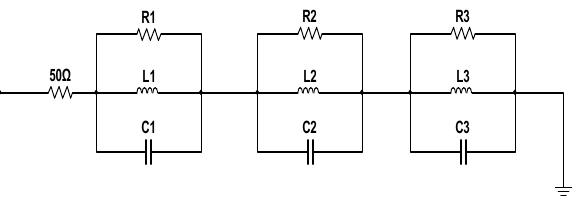
Figure 6. The equivalent circuit of the proposed antenna. Table 2. The parameters of RLC equivalent circuit of the proposed antenna. Parameters